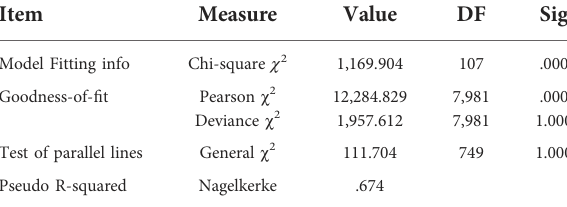
TABLE 2 Ordinal regression results.